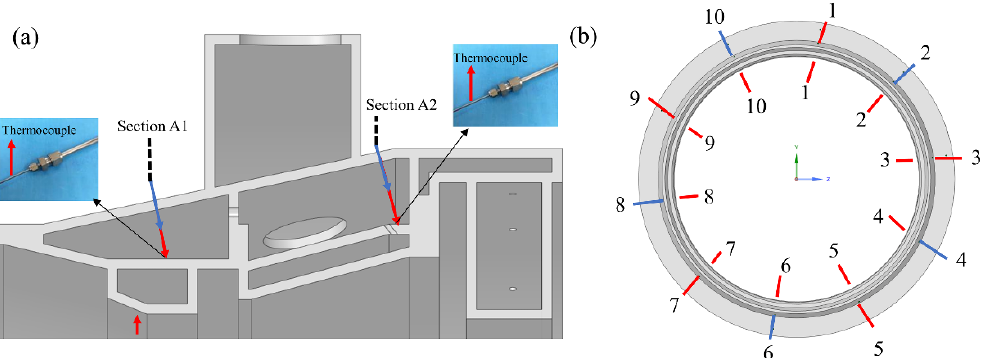
Figure 3. Distribution of measuring position of thermocouples: ( a ) sectional view; ( b ) frontal view. The blue arrows represent the thermocouples for measuring the cavity temperatures, and the red arrows represent the thermocouples for measuring the wall surface temperatures. There are ten thermocouples evenly distributed in the closed cavity formed by the heater and the inner annulus of the casing. When the wall process reaches a steady state,